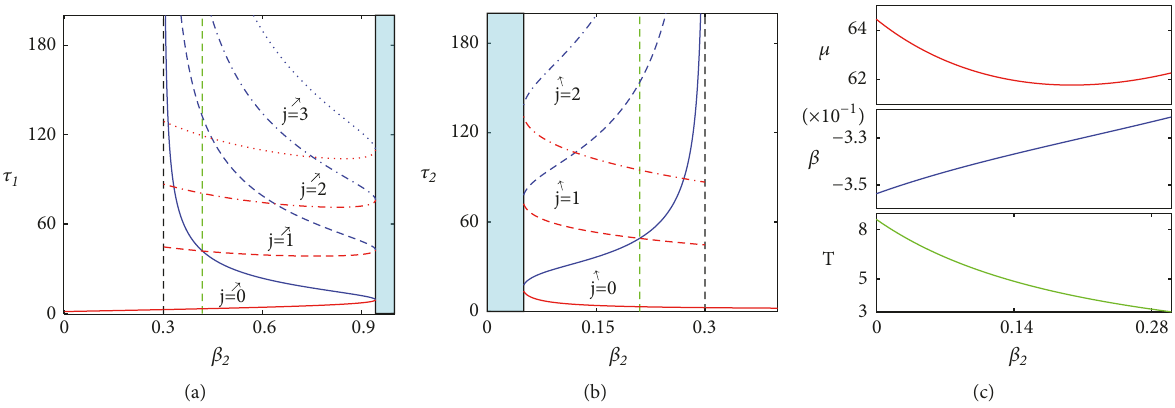
Figure 1: (a) Bifurcation diagram with 𝜏 2 = 0 corresponding to 𝜏 1 V.S. 𝛽 2 , where solid, dashed, dash-dot, and dotted curves represent the critical values of 𝜏 1 in (30) for j = 0, 1, 2,3 , respectively, and the green dashed line denotes 𝛽 2 = 0.417238 . (b) Bifurcation diagram with = 0 corresponding to 𝜏 𝛽 𝜏 1 2 V.S. 2 , where solid, dashed, dash-dot, and dotted curves represent the critical values of respectively, and the green dashed line denotes 𝛽 2 = 0.21 . (c) Examples for 𝜇 , 𝛽 , and T at 𝜏 1 = 𝜏 10 with respect to 𝛽 2 , where 𝜏 2 = 0 .